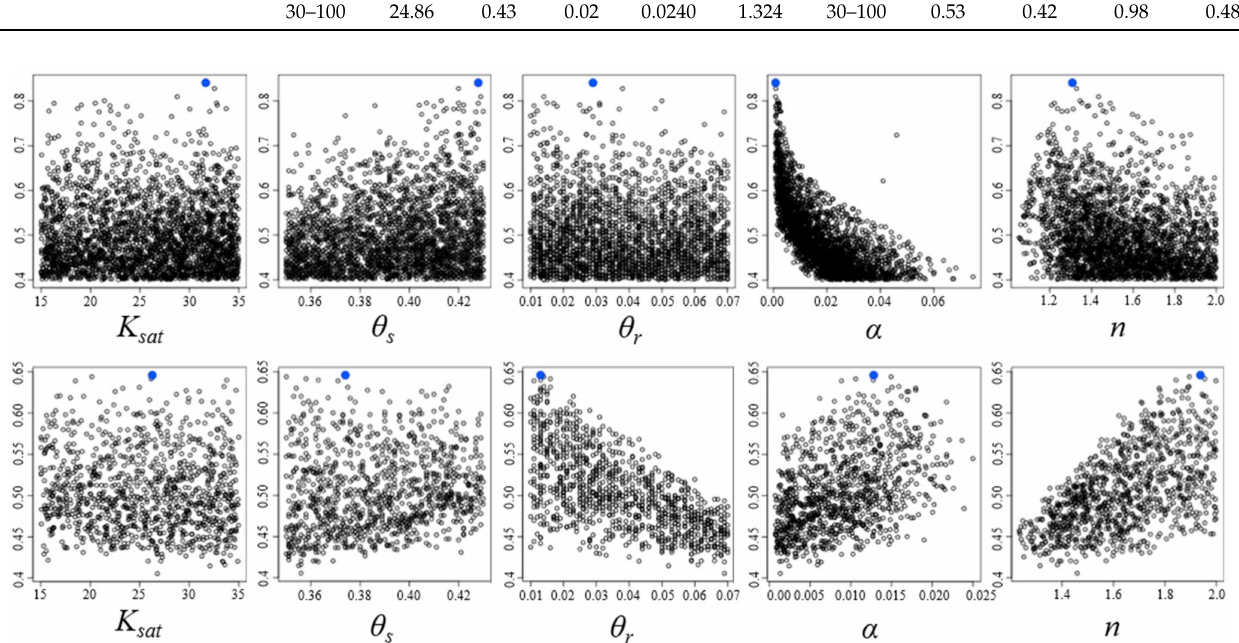
Figure 10. Dotty plots, for the parameters considered for the two runs ( I-b and I-d ). The blue dots represent the parameter combination (optimized parameter) with nRMSE. The y-axis shown here represents the correlation. K sat , θ s , and θ r are saturated hydraulic conductivity, saturated water content, and residual water content, respectively. α is related to the inverse of the air entry suction and n is a measure of the pore-size